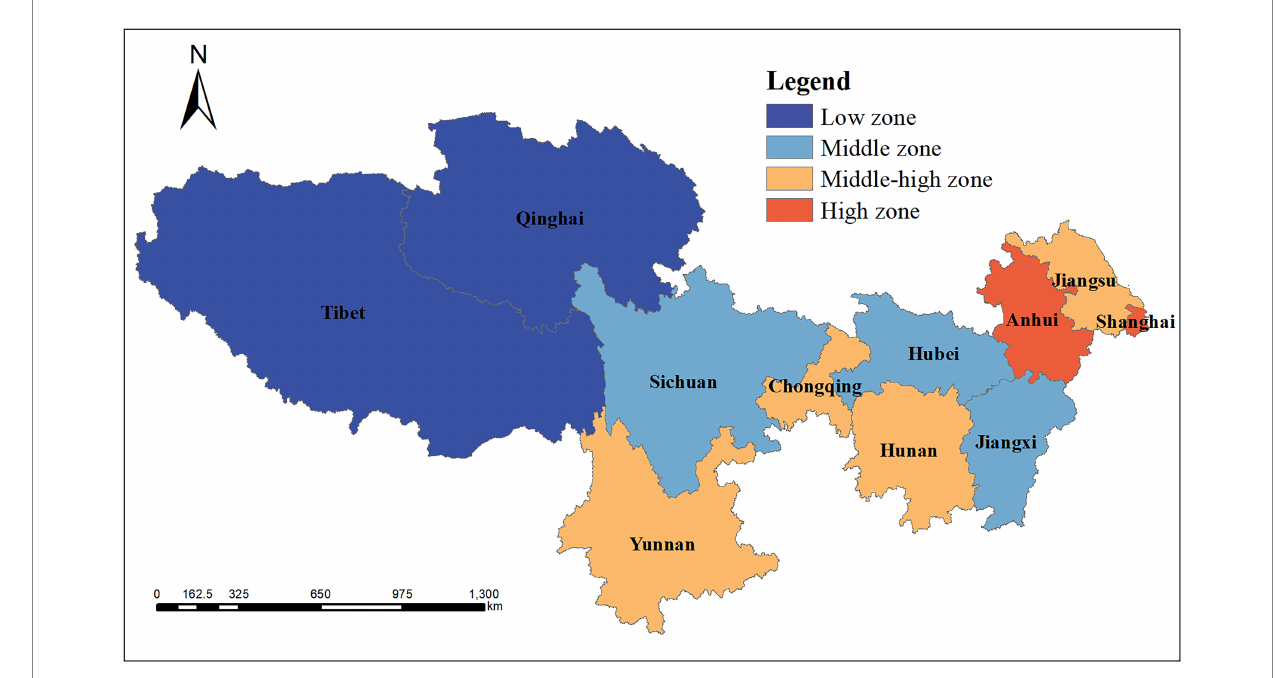
FIGURE 6 Spatial patterns of tourism economic development in the Yangtze River basin.